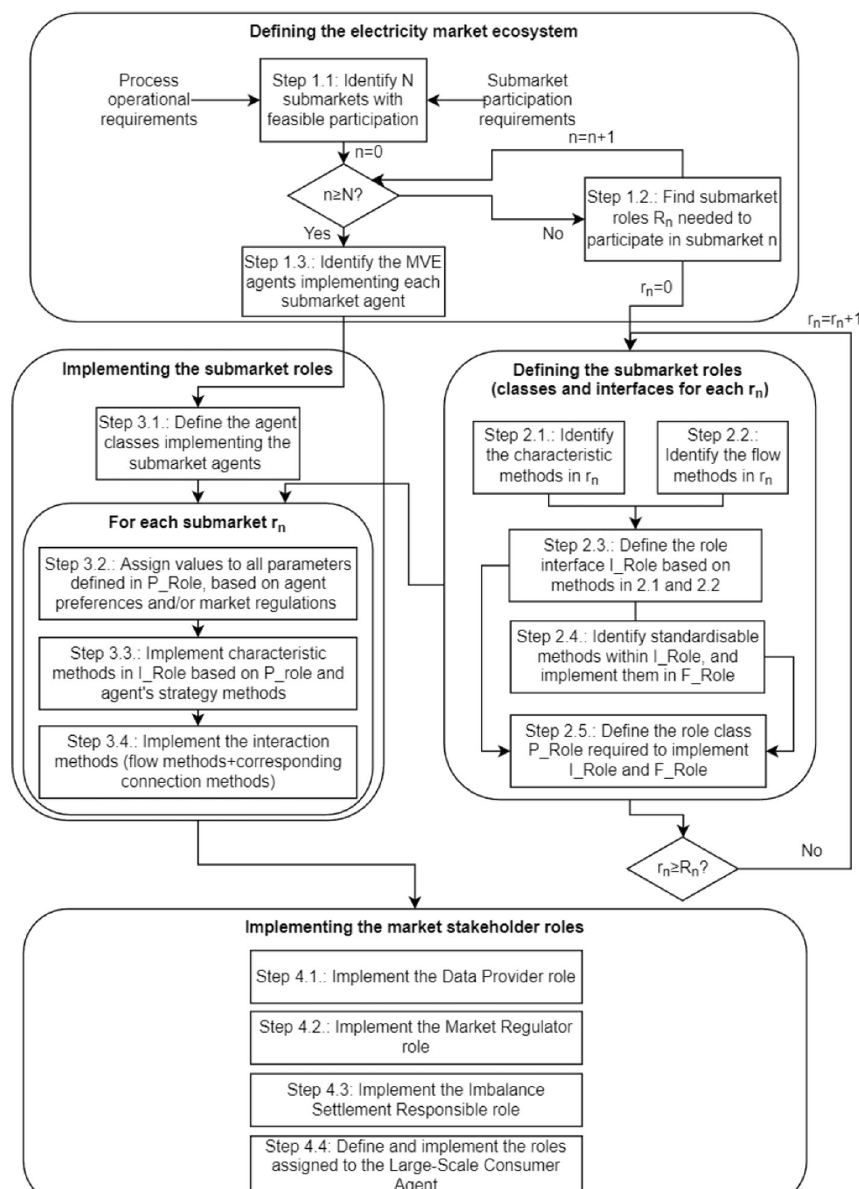
Fig. 5 Flowchart of modelling setup